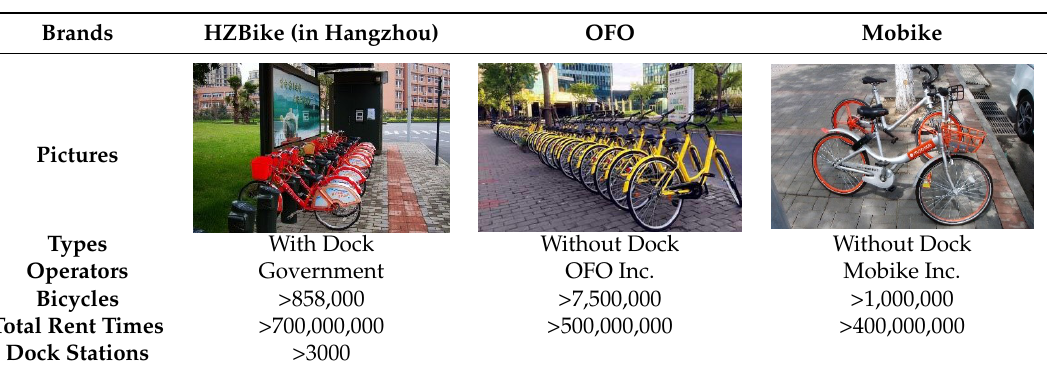
Table 3. Examples of present shared bicycle in China (accessed by July